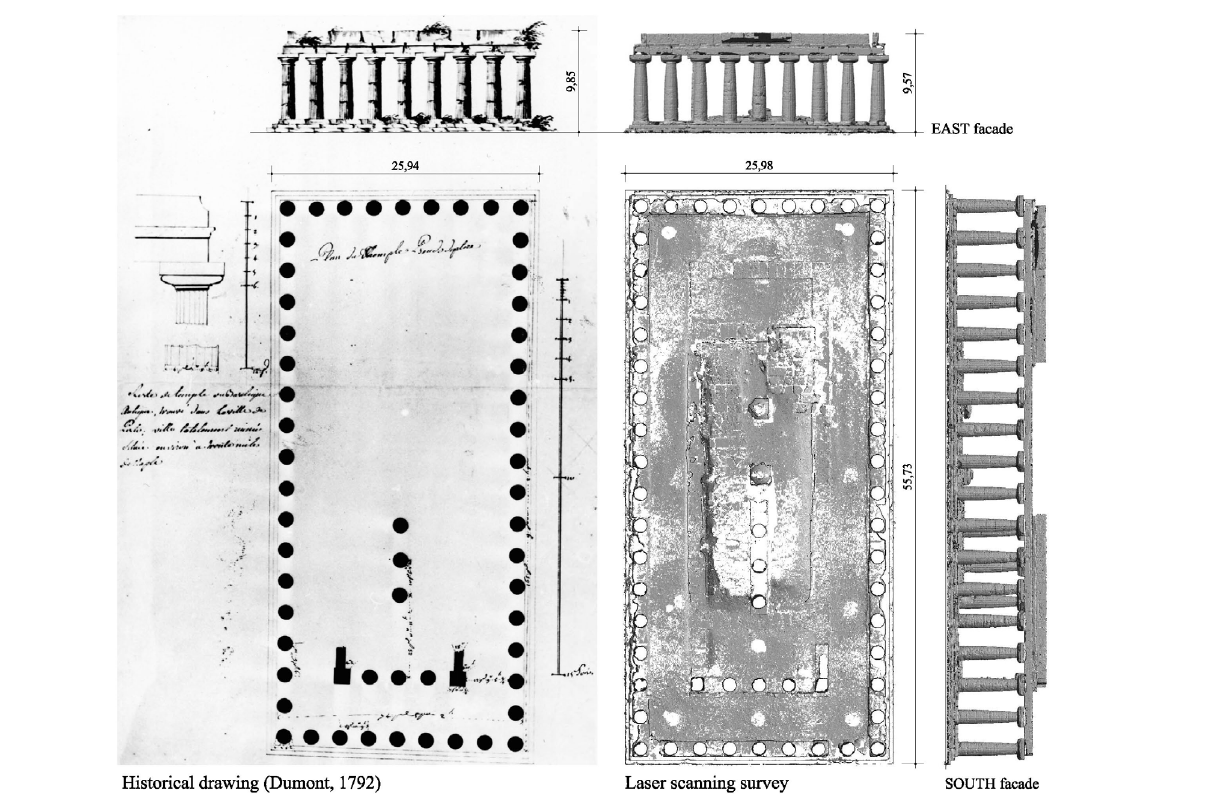
Figure 4: Plan and facade of the “Basilica”: comparison between the results achieved from the laser scanning data and those produced by historical surveys (Dumont, 1792).